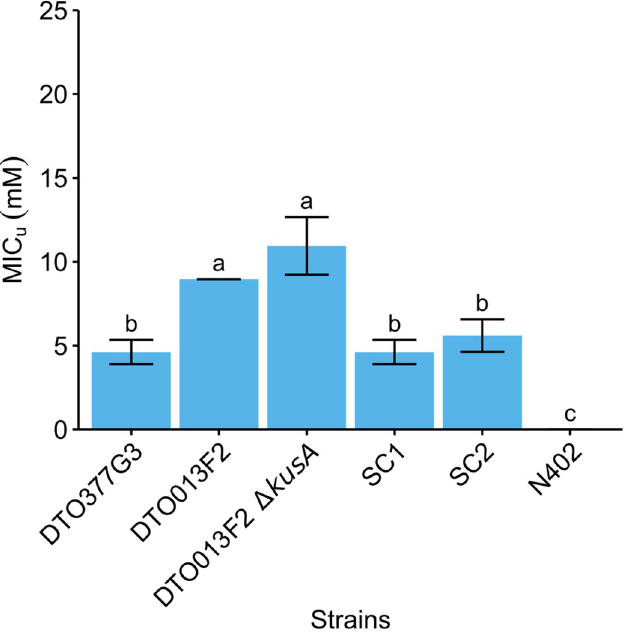
Fig 9. Sorbic acid resistance of five P . roqueforti strains and A . niger N402. The average MIC u (mM ± standard deviation) is given for the fungal strains. Each bar graph represents average value of biological independent triplicates. Error bars indicate standard deviation and letters indicate significant difference in MIC u (p <